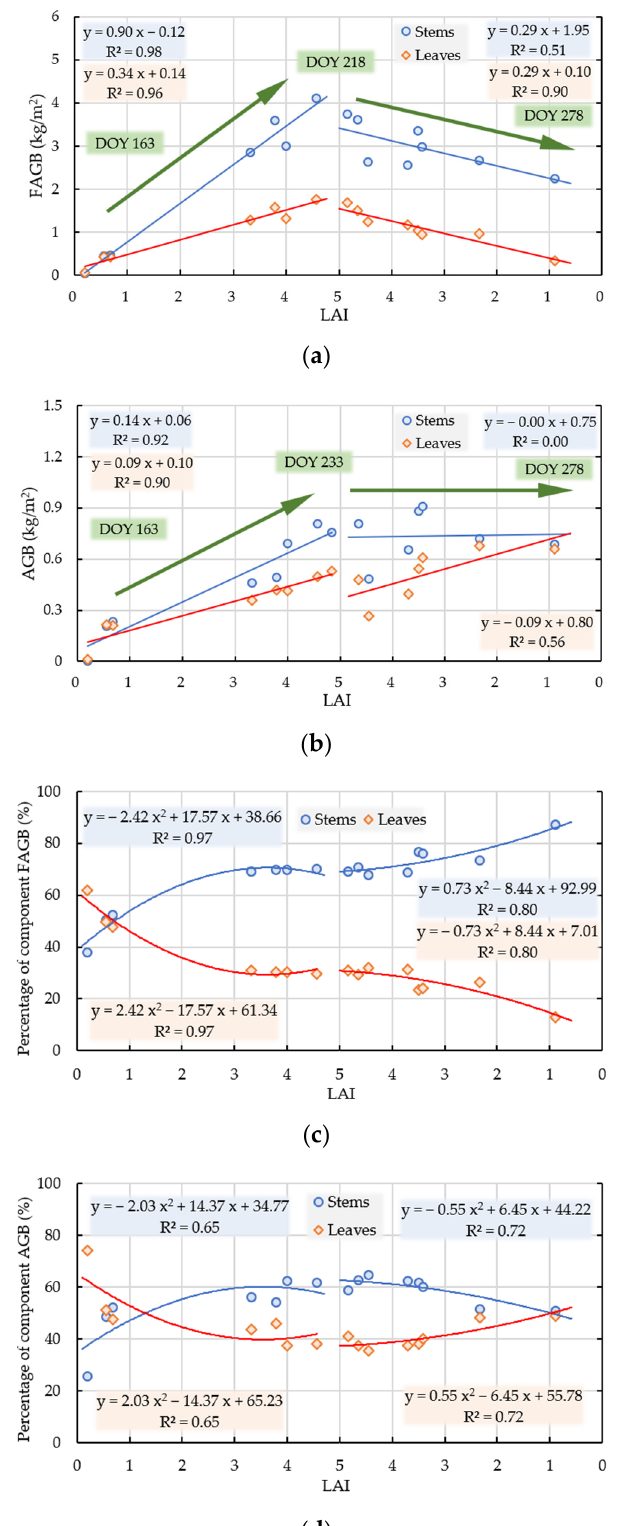
Figure 5. The allocation characteristics and component contribution relationships of the FAGB ( a , c ) and AGB ( b , d ) throughout the growing season.